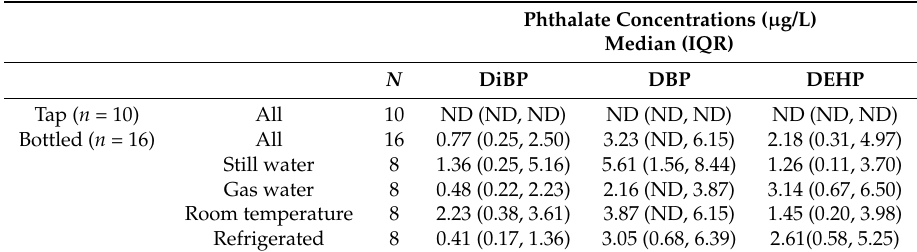
Table 1. Concentrations of phthalates in tap and bottled water samples.